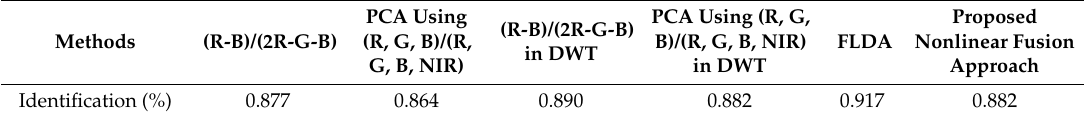
Table 5. Processing time (second) for different classification methods.